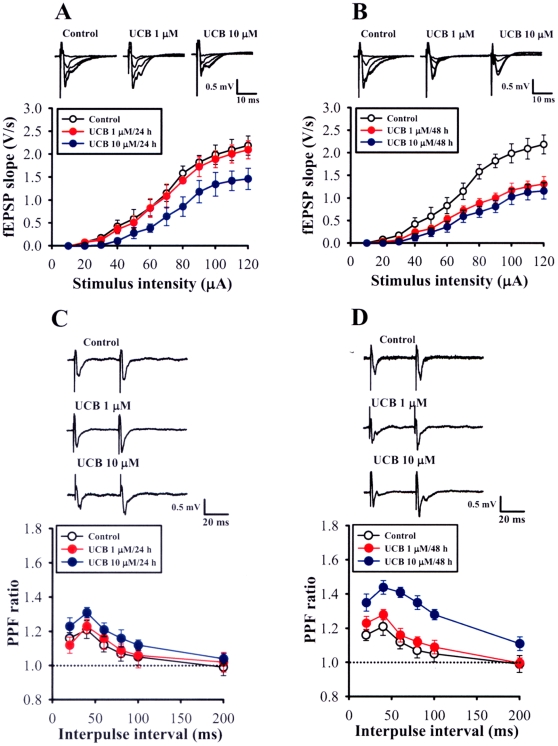
Effects of prolonged UCB exposure on basal synaptic transmission and paired-pulse facilitation (PPF).(A, B) Input-output curves of field excitatory postsynaptic potentials (fEPSPs; V/s) versus stimulus intensity (µA) at the Schaffer collateral-CA1 synapses of hippocampal slice cultures in the absence (control) or presence of 1 or 10 µM UCB for 24 h (A) or 48 h (B). Inset shows example fEPSPs (average of three responses) recorded in slices from control and UCB-treated slices. (C, D) Comparison of PPF ratio in slices from control and treated with 1 or 10 µM UCB for 24 h (C) and 48 h (D). The plot summarizes facilitation of the second fEPSP slope relative to first one as a function of the interpulse intervals of 20 to 200 ms. Inset shows example PPF (average of three responses) obtained with interpulse interval of 40 ms in slice from control and UCB-treated slices. Error bars indicate SEM.